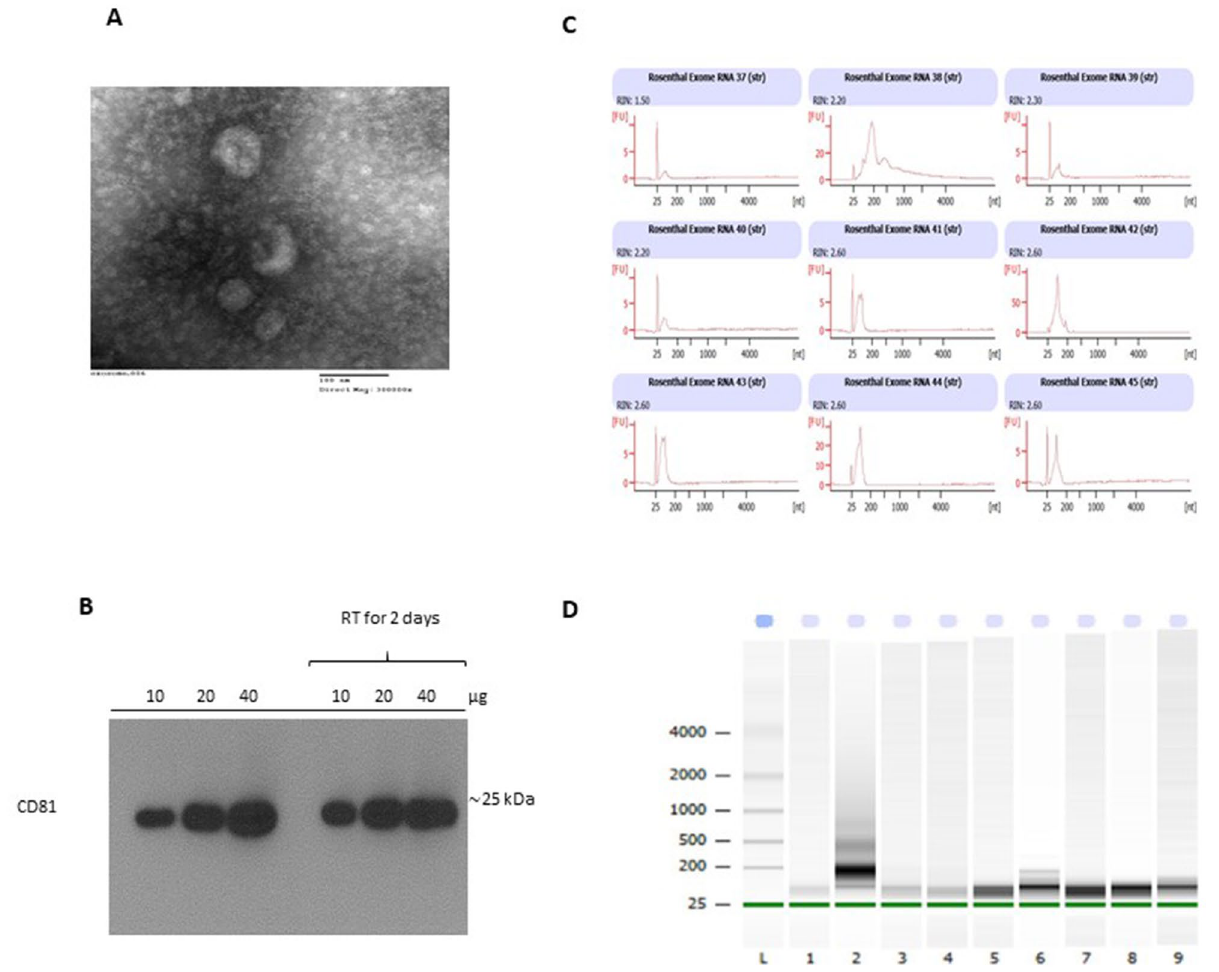
Figure 2. Human Milk Exosome characterization and RNA isolation. ( A ) Transmission electron micrograph of human milk exosomes demonstrates small vesicles with sizes ranging from 30 to 100 nm in diameter (Magnification: × 300,000; Scale bar 100 nm) ( B ) Western blotting for exosome-associated marker protein CD81. 10, 20, and 40 µg of proteins from either freshly isolated or human milk exosomes kept at room temperature (RT) for 2 days were loaded ( C ) Electropherogram and ( D ) gel images of representative RNAs extracted from human milk exosomes run on Agilent 2100 Bioanalyzer. Lanes 1–9 correspond to 37–45 samples; L